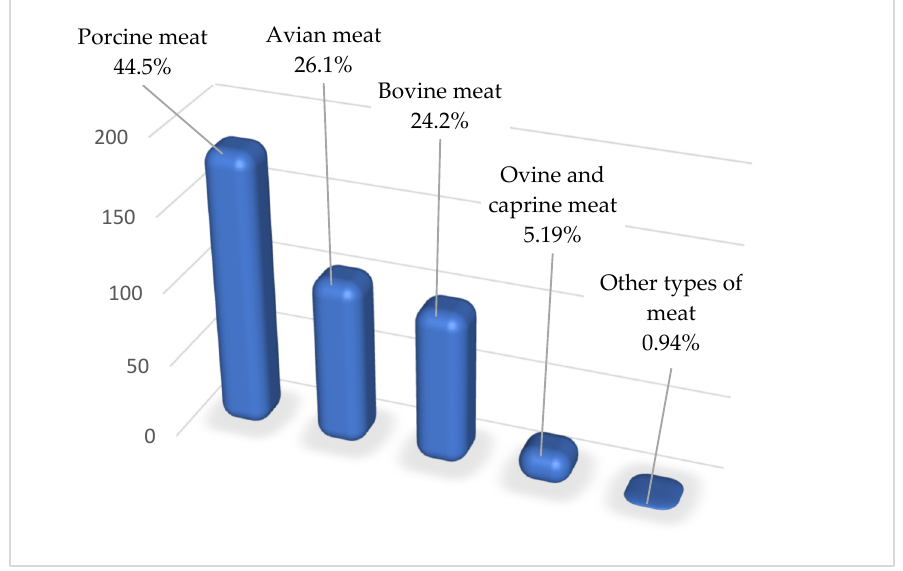
Figure 3. The water footprint of each type of meat in Romania residents (m 3 inhabitant − 1 year − 1 ).